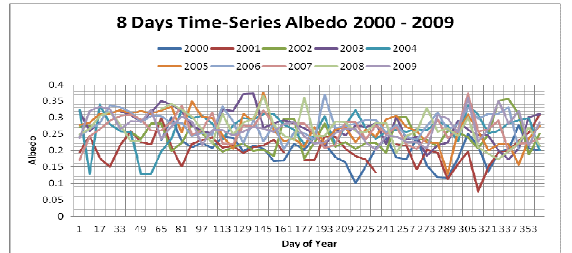
Figure 3. Daily Albedo 2000 -